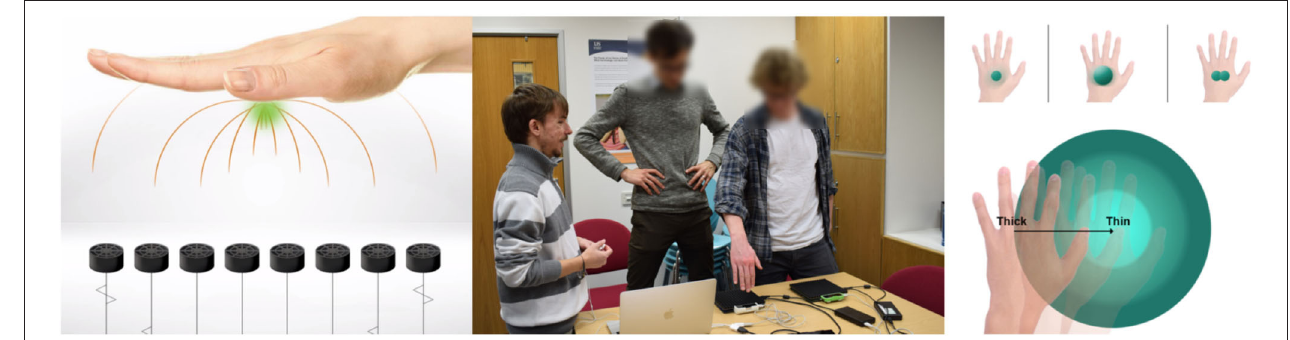
FIGURE 1 | Ultrasonic mid-air haptic technology (left) enables the creation of tactile sensations without attachments to the hand. We developed six mid-air haptic probes (right) of science concepts from particle physics, quantum mechanics, and cell biology; and then run workshops with science communicators from each of those three scientific fields (middle)